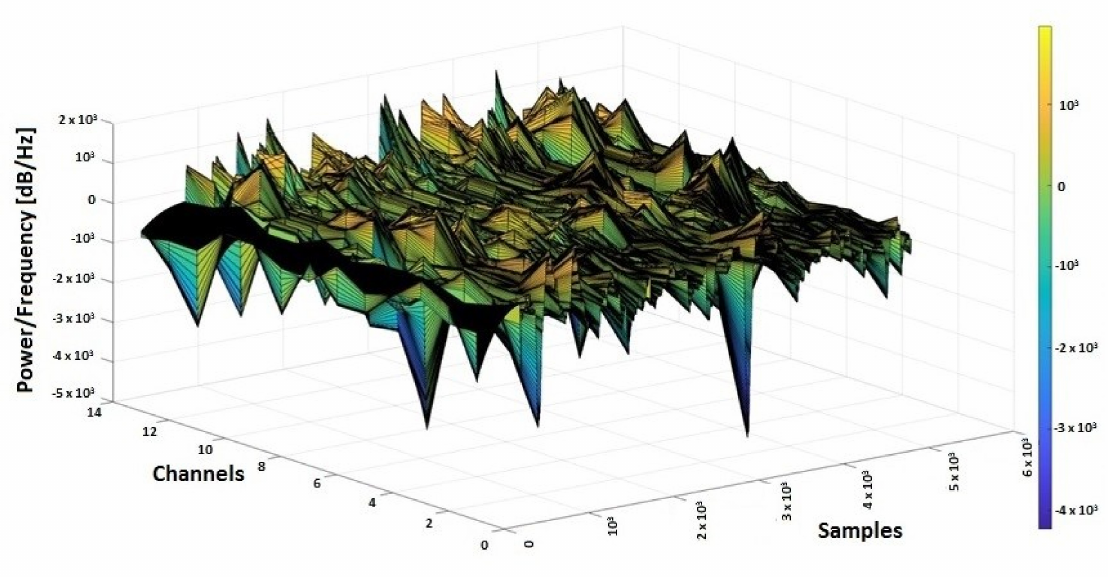
Figure 5. 3D spectrogram of EEG signals from 13